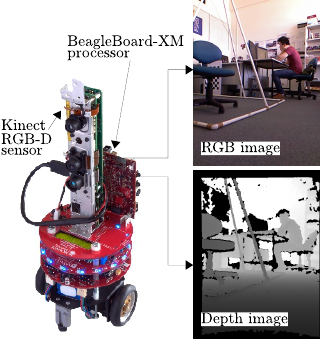
Figure 11. eyeBug [69,70], the mobile RGB-D sensor we used in our experiments. The color and depth data generated by the Kinect sensor is processed on a BeagleBoard-xM [71] computer running the GNU/Linux operating